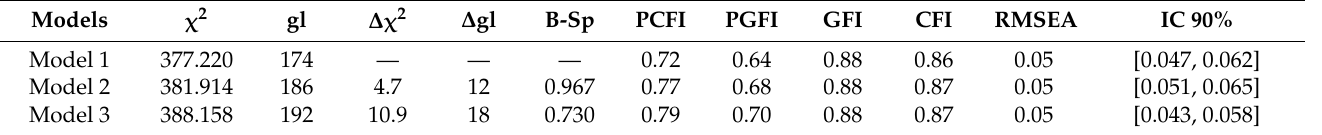
Table 5. Results of the CFA multi-group analysis of the AAQp